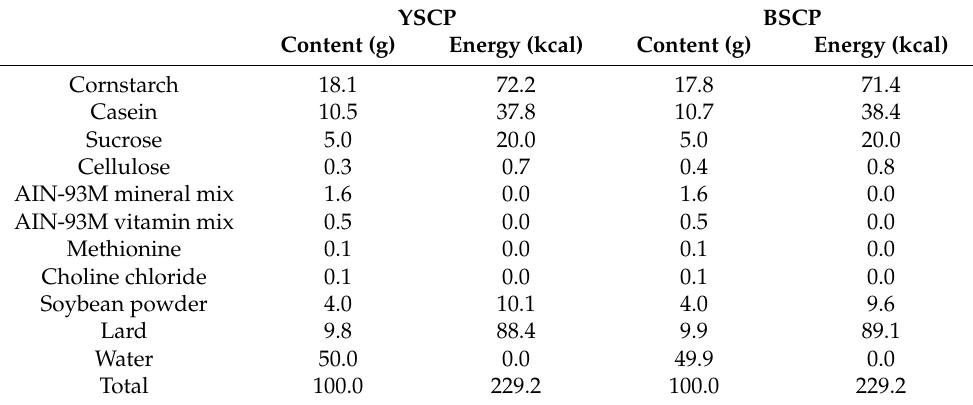
Table 2. Chemical composition of experimental diets